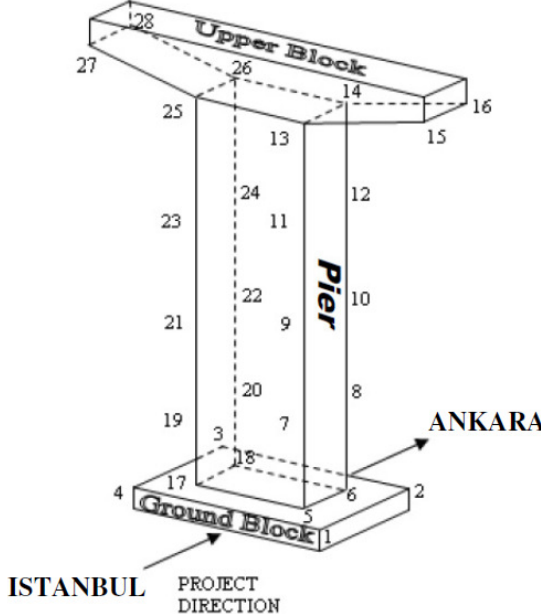
Fig. 5. Control points on the viaduct. Figure 5: Control points on the viaduct The transformations commenced from pier 1 left and right in the D ¨ uzce to Bolu